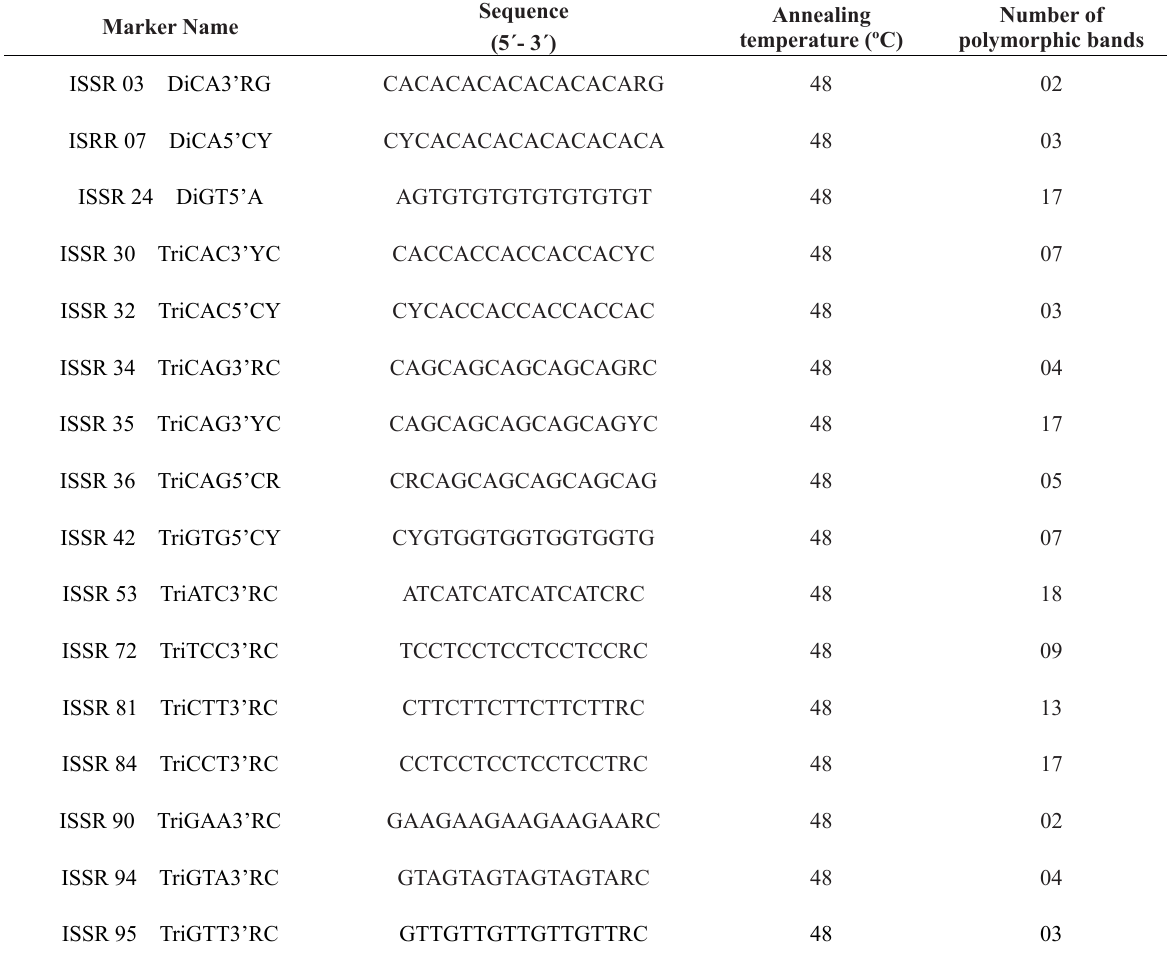
Identification and sequences of the 16 ISSR primers used in the genetic diversity study of 11 pineapple